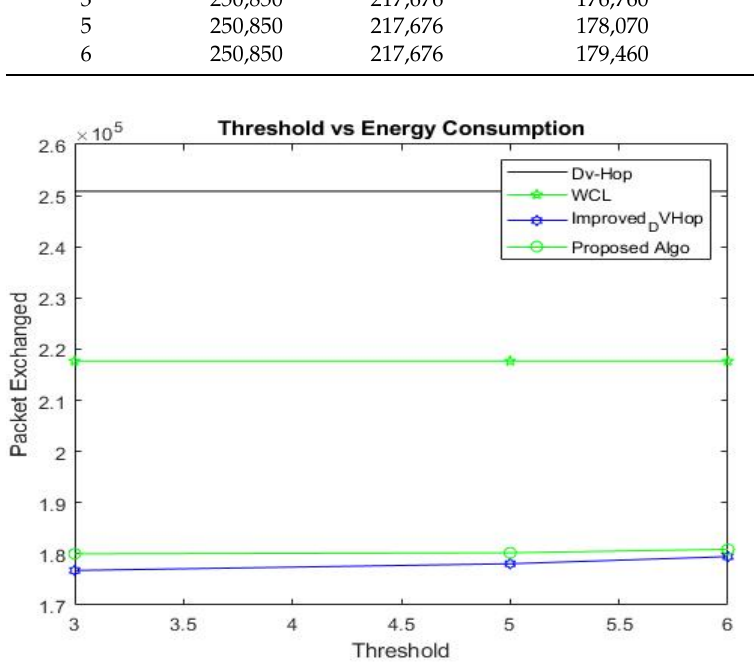
Figure 11. Threshold vs. energy consumption.